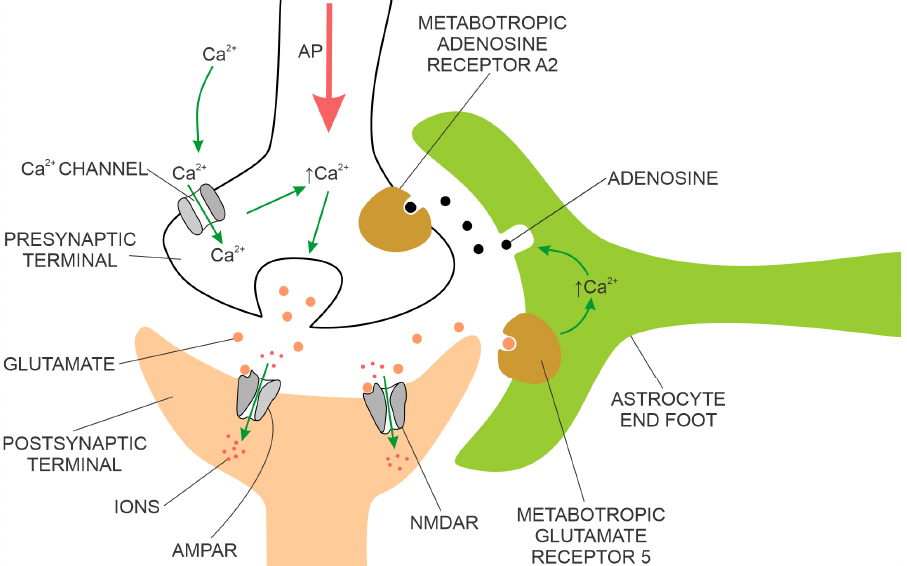
Figure 2. The tripartite synapse. Abbreviations: AMPAR ( α -amino-3-hydroxy-5-methyl-4-isoxazolepropionic acid receptor), NMDAR (N-methyl-D-aspartate receptor, tetrameric protein with two GluN1 subunits and two GluN2 (A-D) subunits, a type of L-glutamate receptor). The AP with red arrow represents the direction of action potential transmission.